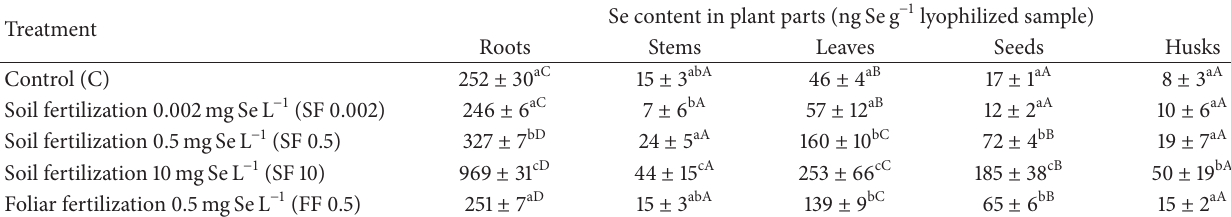
Table 1: Concentration of Se in plant parts of Tartary buckwheat, treated with different techniques and concentrations of Na selenate.